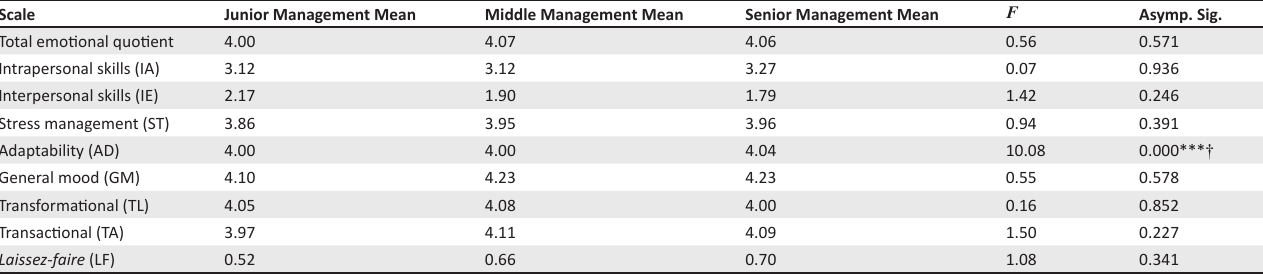
TABLE 5: Significant differences between management level groups: Analysis of variance (ANOVA). Scale